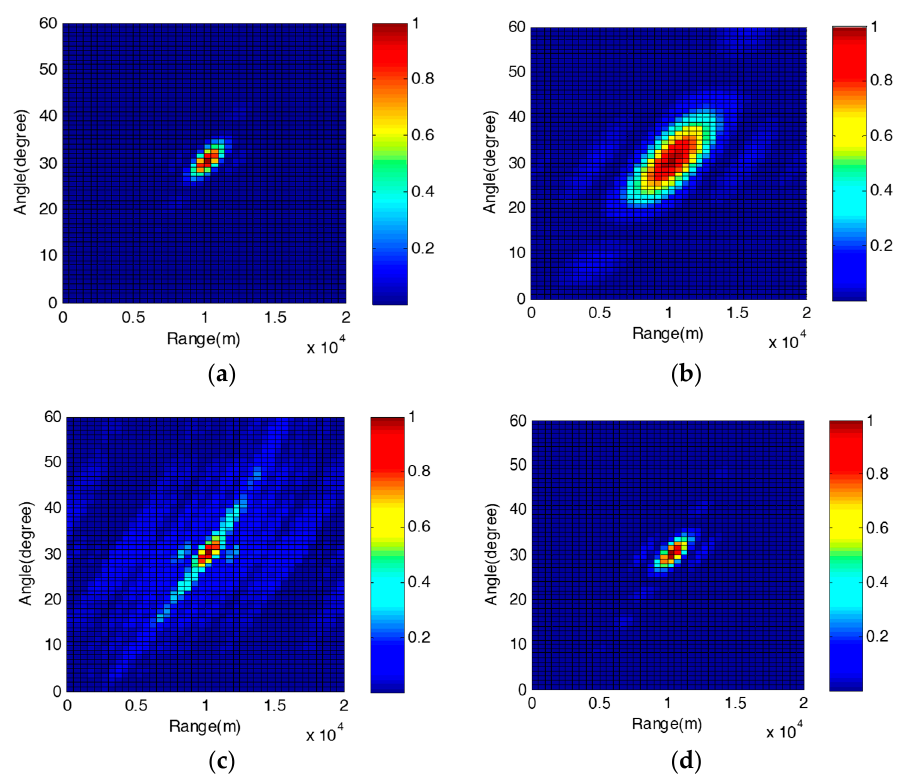
Figure 4. Normalized beampatterns of FDA-MIMO Radar and NNFDA-MIMO Radar: ( a ) 20-element FDA-MIMO Radar; ( b ) 8-element FDA-MIMO Radar; ( c ) 8-element NNFDA-MIMO Radar direct; ( d ) 8-element NNFDA-MIMO Radar augmented.